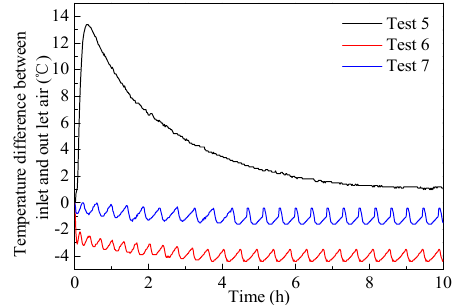
Figure 16. Variation of the temperature difference between inlet and outlet air with time.